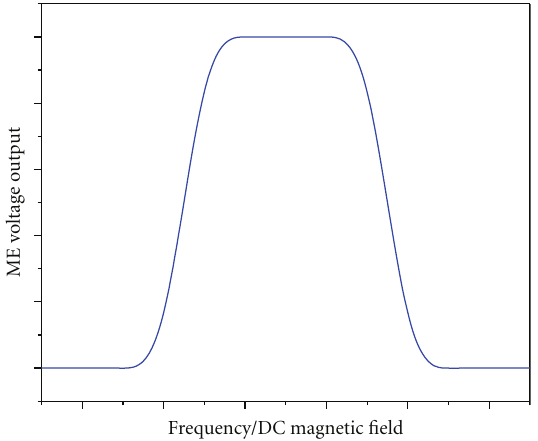
Figure 1: Schematic diagram of an ideal broadband/wideband ME